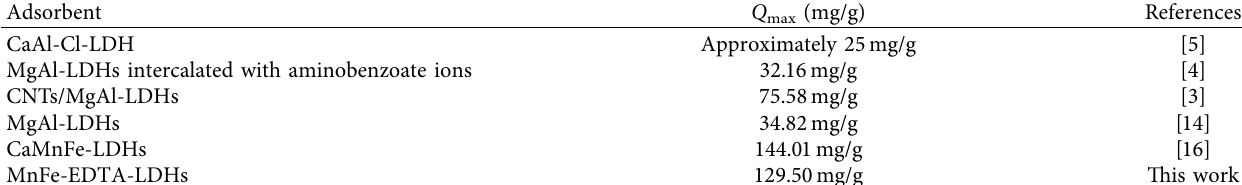
Table 4: Comparison of the Cl − adsorption capacity of diferent adsorbents.